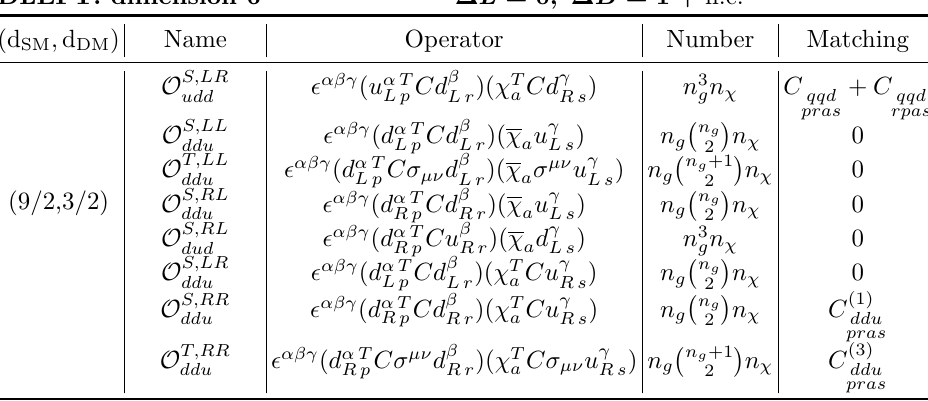
Table 33 . Dimension-six ∆ L = 0 , ∆ B = 1 operators in DLEFT. The first column gives the dimensions of the SM and DM part of the operator, the fourth column is the number of operators, and the fifth column is the additional matching contribution at the EW